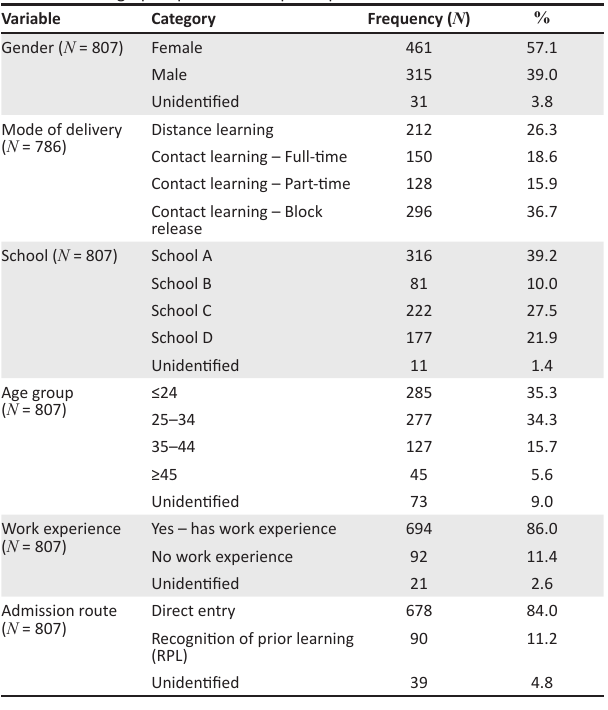
TABLE 1: Demographic profile of the participants. Variable